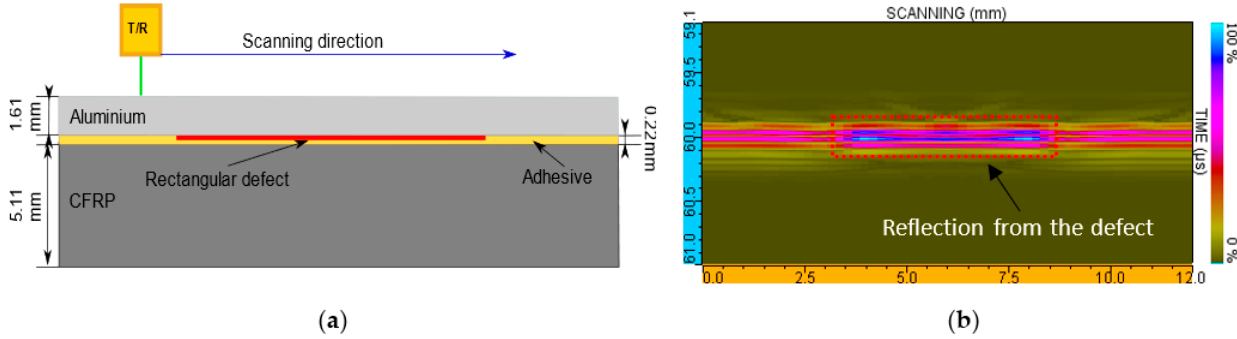
Figure 4. Calibration of inspection simulation on a rectangular-type defect to determine the reference amplitude required for metamodel estimation: ( a ) Set-up of inspection simulation; ( b ) Resulting B-scan.